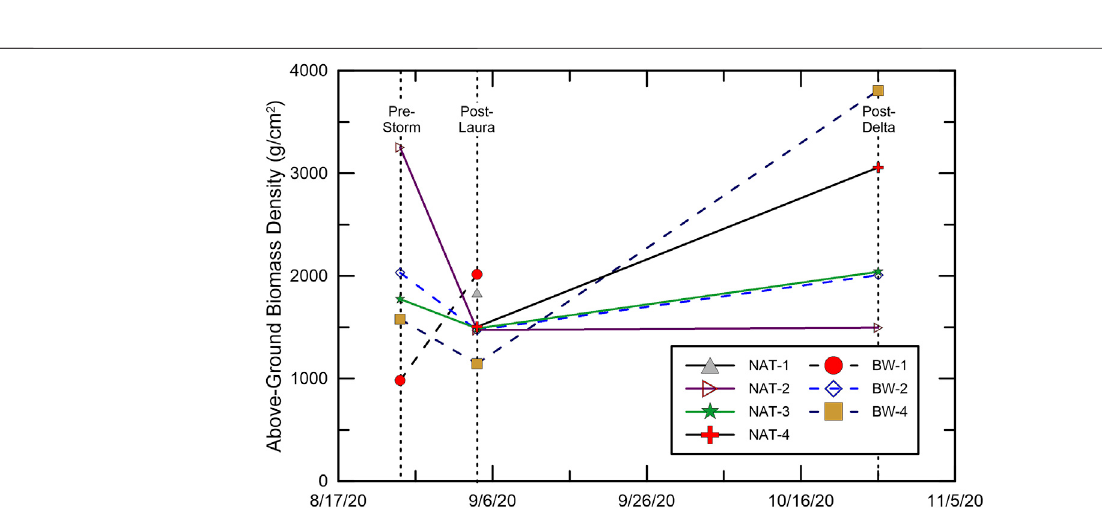
Frontiers in Built Environment |